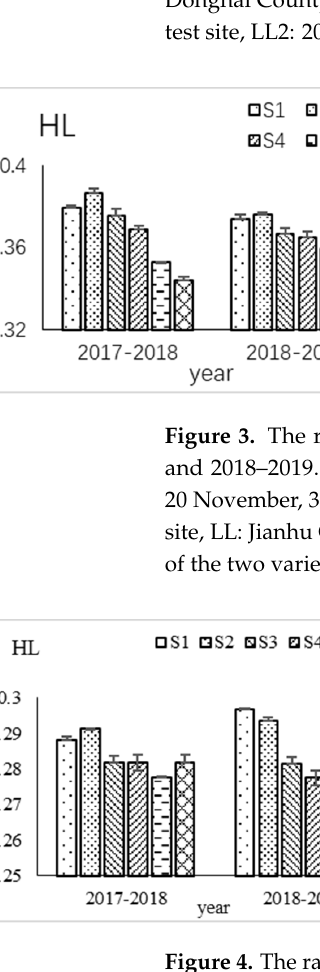
Table 8. Correlation between temperature and radiation on dry matter of spring wheat in different periods at Donghai County. EM ‐ JO